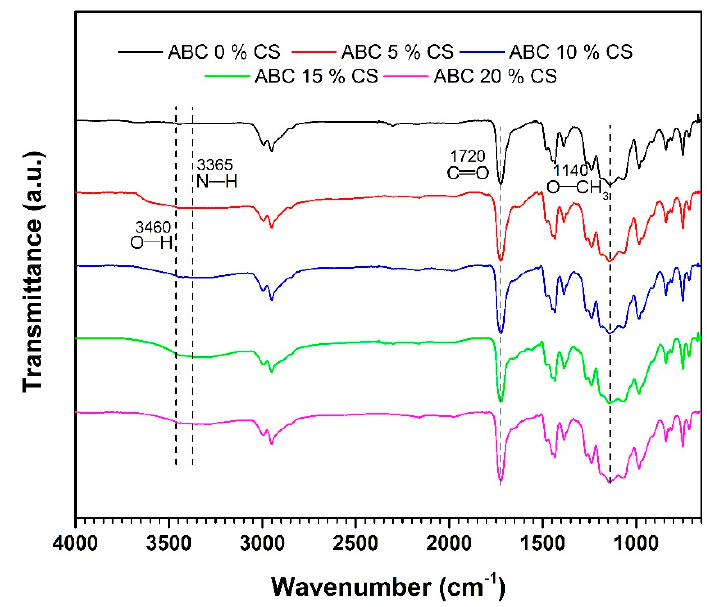
Figure 1. Fourier-transform infrared spectra in attenuated total internal reflectance mode (ATR) mode for ABCs loaded with chitosan (CS).